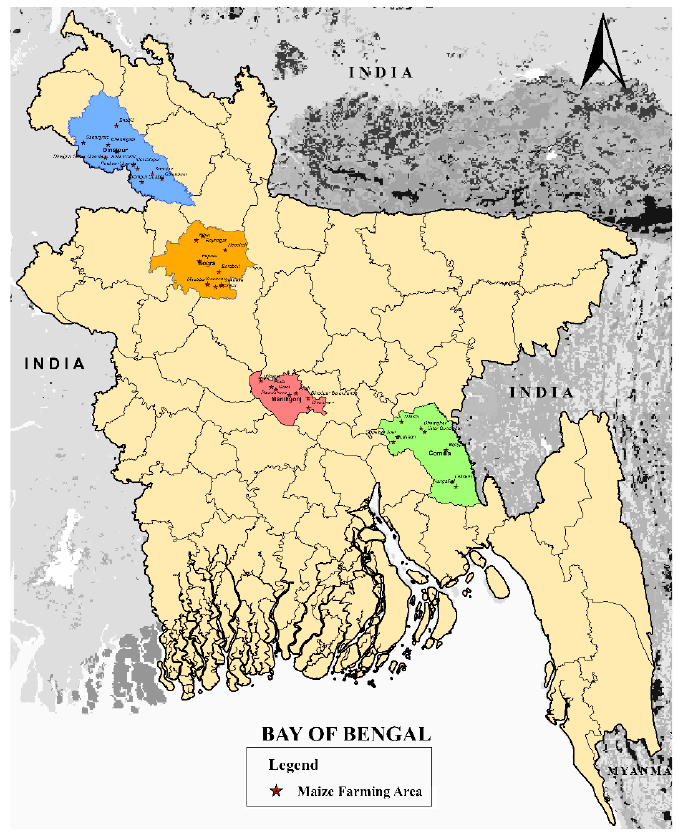
Figure 2. GIS (Geographic Information System) map of the study areas.